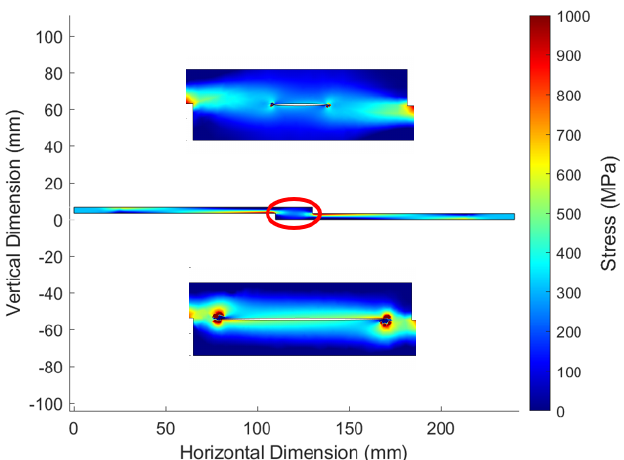
Figure 16. TSA stress distribution map for the SLJ with the respective zooms around the defect. As the TSA technique only allows surface measurements, the stress analysis on one of the two plies surfaces was of most interest. Therefore, the stress profile along the bottom surface of the bottom ply was plotted for the three different meshes, as presented in Figure 17. The vertical lines correspond to the beginning and end of the defect, for the respective mesh, with the center of the defect being at x = 120